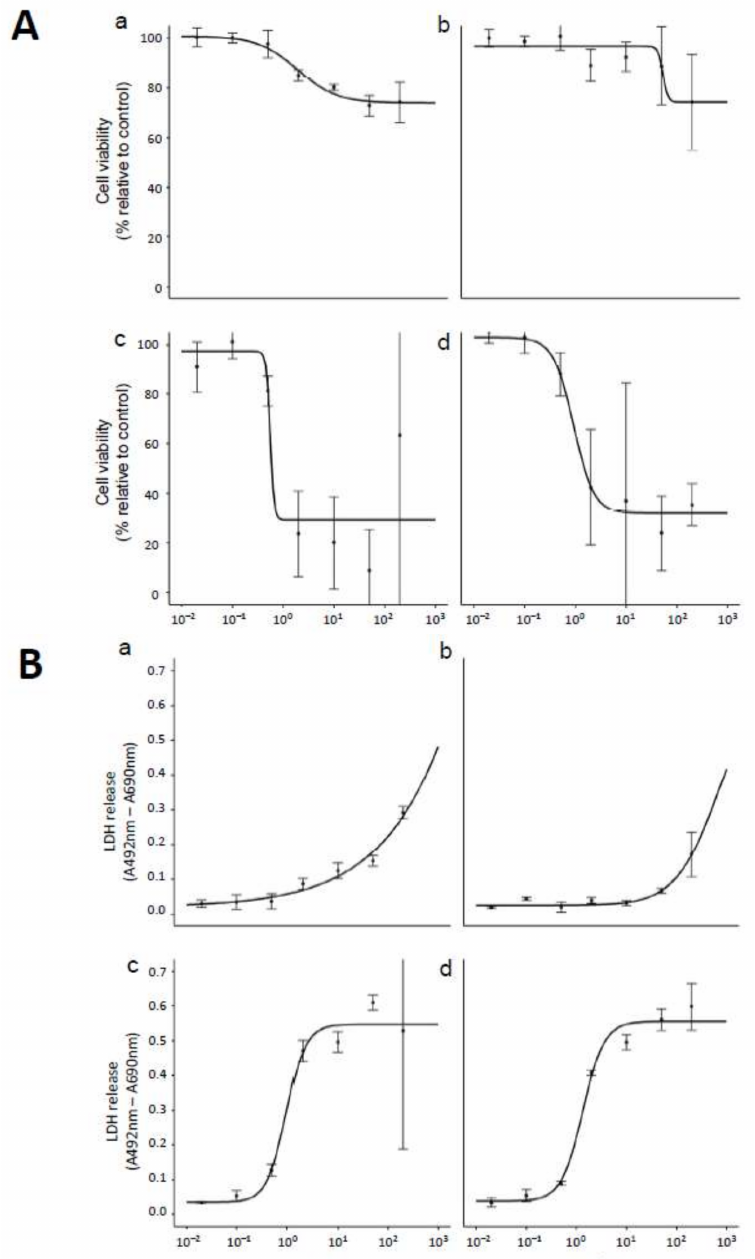
Figure 2. Effects of FeO x NPs on BEAS-2B cell viability and membrane integrity. Cells were treated with γ -Fe 2 O 3 (a), α -Fe 2 O 3 (b), Fe 3 O 4 (c) and FeO x -mix (d) in a range of concentrations from 0.02 to 200 g/mL in SCM for 24 h at 37 ◦ C then ( A ) cell viability was measured using CCK-8 assay and ( B ) membrane integrity was measured by lactate dehydrogenase (LDH) release assay. Data represent means and SD of three technical